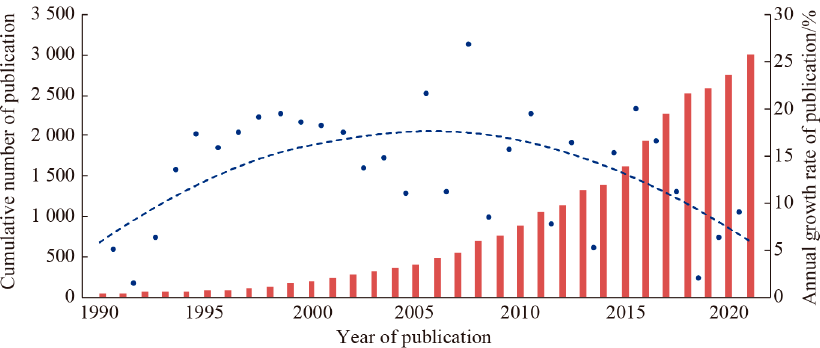
Figure 1. Cumulative number and annual growth rate of publications in the grassland ecosystem field from the Web of Science database